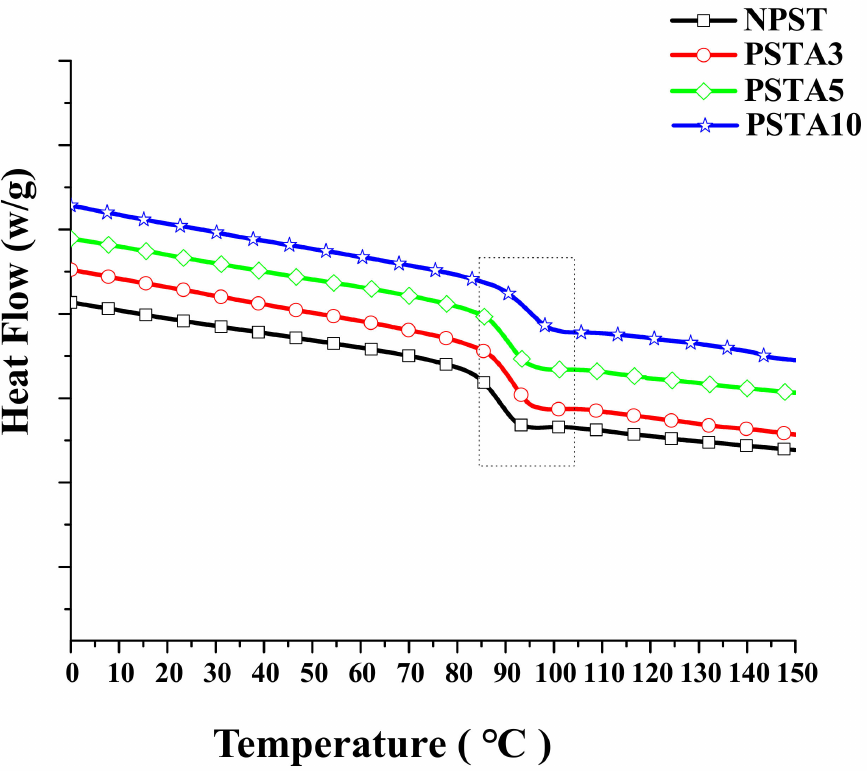
Figure 13. The measured heat flow curves from DSC for the Type II